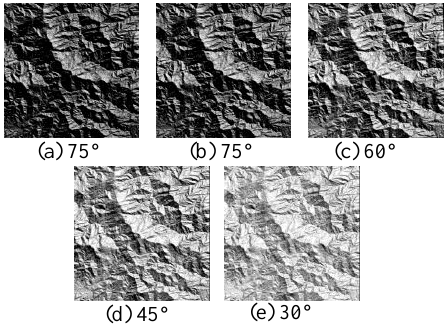
Figure 8. Terrain shading images of different zenith angles and the same azimuth angle